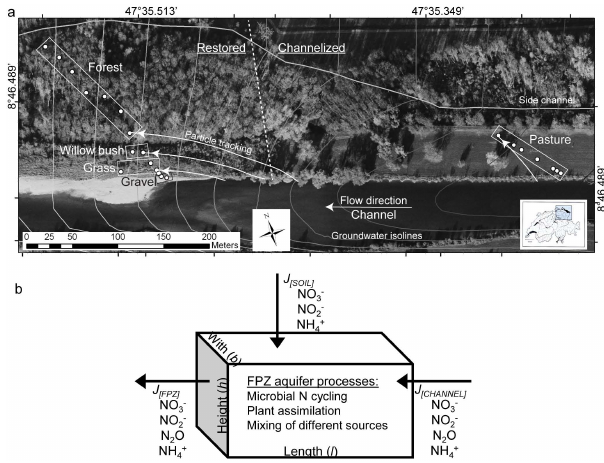
Fig. 1. (a) Field site at Niederneunforn, Switzerland, with the in- stalled piezometers in the restored and channelized section of the river Thur and the different FPZs indicated. The modeled ground- water flow field (Diem et al., 2012) is illustrated by isopotential lines (equidistance of 10cm) and by selected flow paths. To ease a comparison with previous studies, e.g. Vogt et al. (2010) and Schneider et al. (2011), the link to the original piezometer names is given here for the individual FPZs, beginning with the piezome- ter closest to the main channel: gravel: R050 and R060; grass: R042, R051, and R052; willow bush: R041 and R058; forest: R017, R023, R024, R019, R025, R026, and R021; and pasture: R001, R004, R005, R009, R011, R012, and R014. (b) Schematic illustration of the N groundwater budget. River channel and the soil are the two main sources for the groundwater N pool, and the individual FPZs are directly connected to the